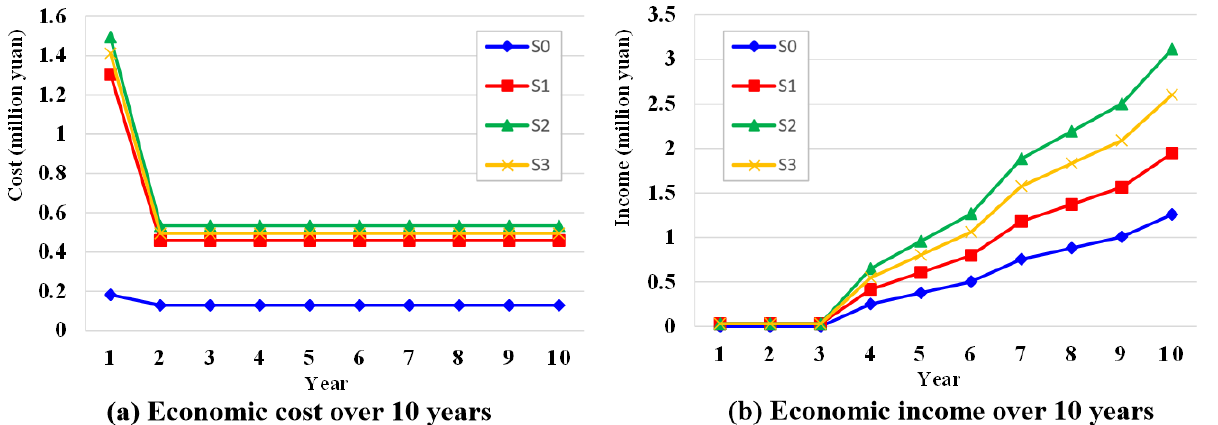
Figure 6. The economic cost and income over 10 years for all scenarios. ( a ) The economic cost over 10 years for all scenarios. ( b ) The economic income over 10 years for all scenarios.